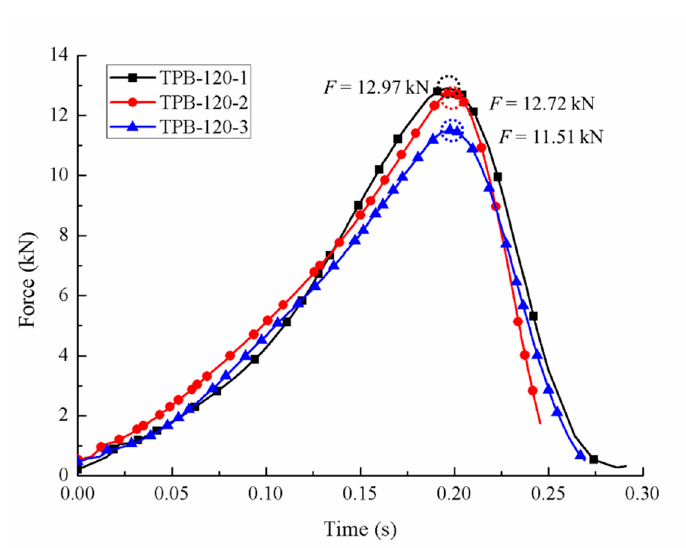
Figure 8. Force-time curves with the loading velocity of 120 mm/min.